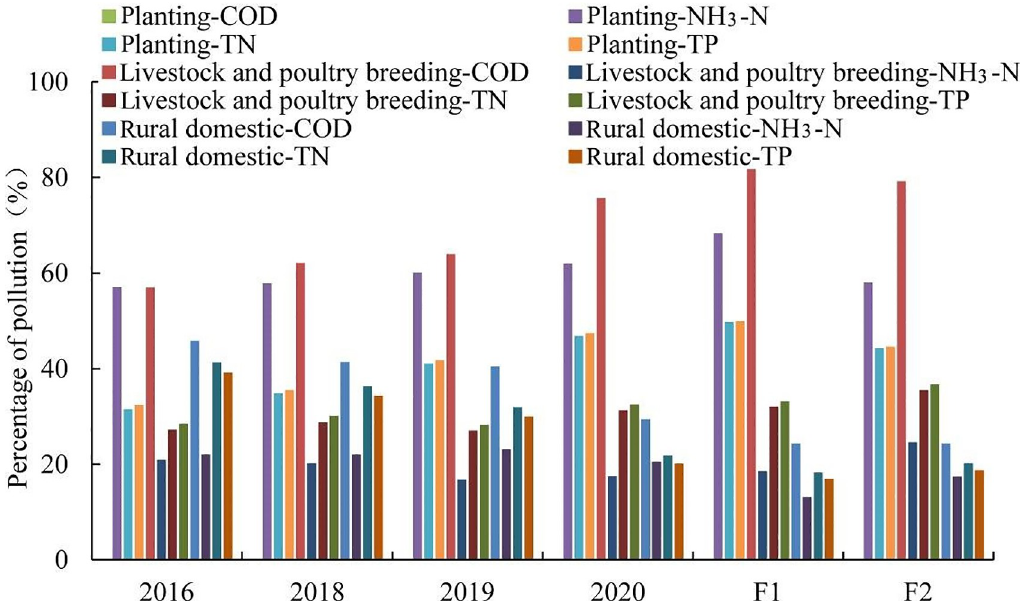
Fig 6. Percentages of potential pollution under different policies.